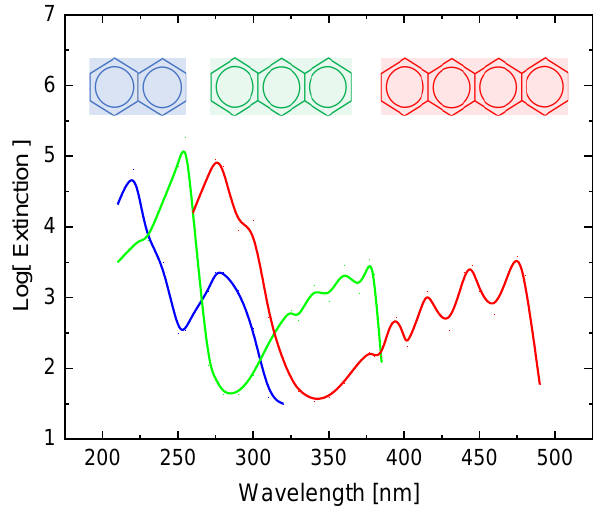
Figure A5. UV absorption of multi-ring aromatic species [47].